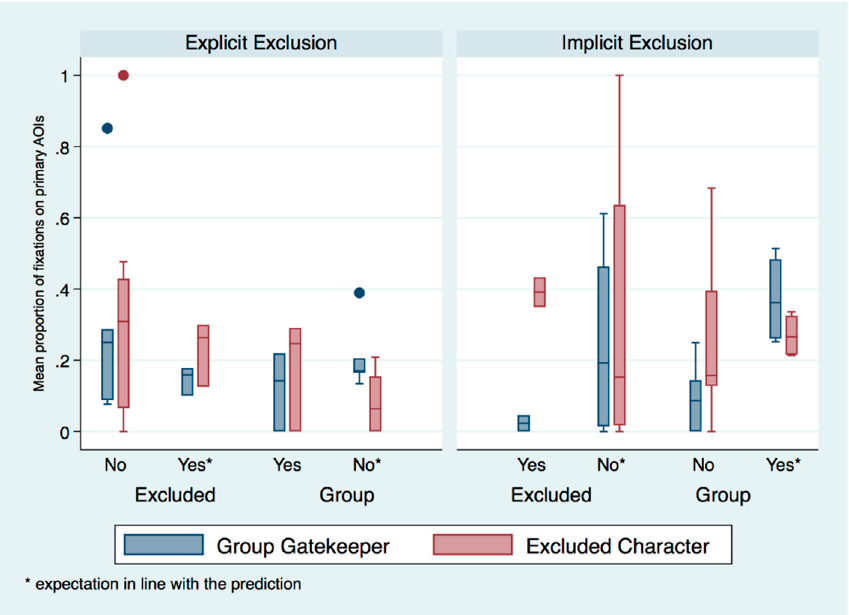
Figure 5. Mean proportion of fixations on primary AOIs as a function of condition, direction and expectation of the movement of the neutral expectation of the movement of the neutral character.